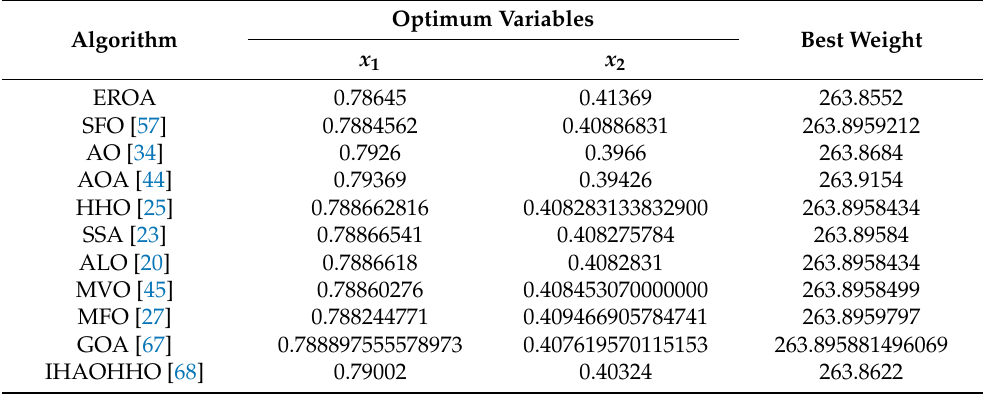
Table 12. Optimization results for the the three-bar truss design problem.